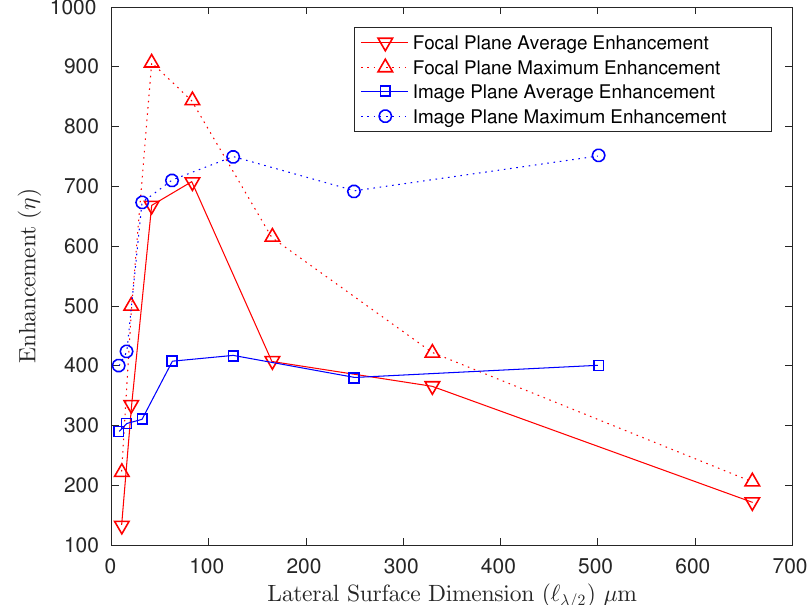
Figure 5. Simulated Enhancement ( η ) vs. Lateral Surface Dimension ( (cid:96) λ /2 ). The red solid line shows average enhancement of the focal-plane system, while the red dotted line shows maximum enhancement. The solid blue line shows average enhancement of the imaging system, while the blue dotted line represents maximum